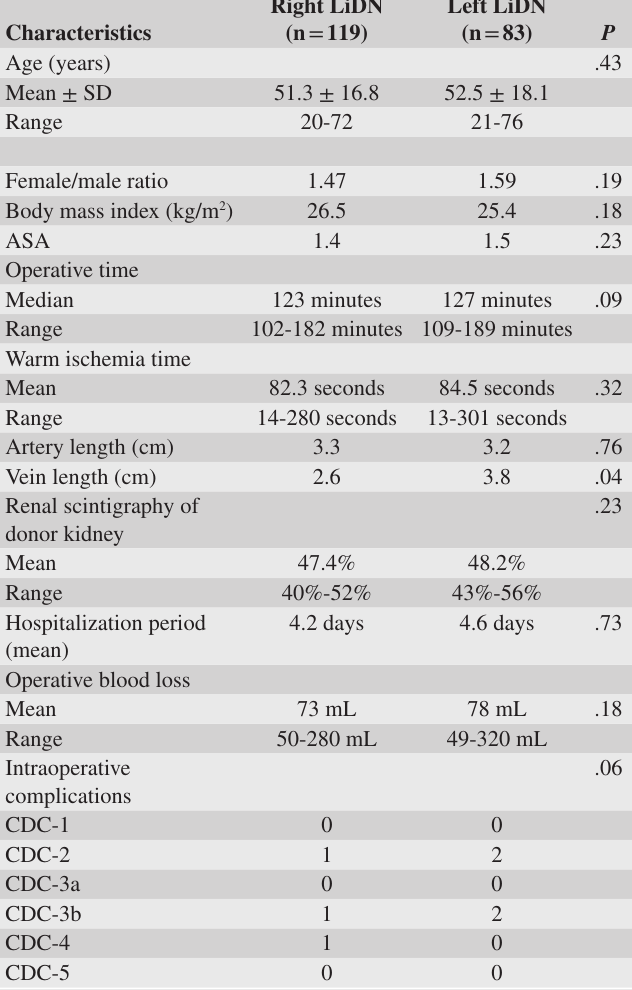
Table 1. Demographic and Operative Characteristics of the Study Population: Right-Sided Versus Left-Sided Donor Nephrectomy